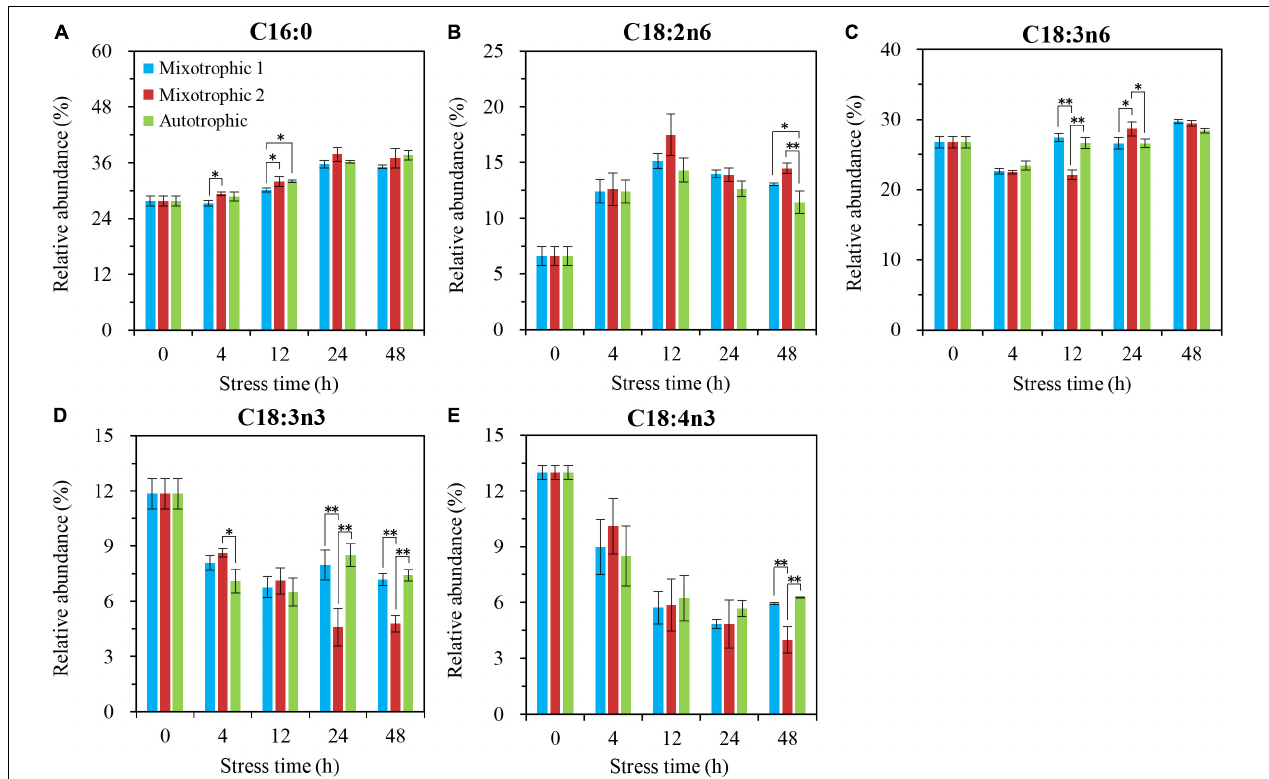
FIGURE 10 | Time course of changes in the relative abundances of the major fatty acyls in DGTS of C. reinhardtii BAFJ5 under three carbon supply regimes over 48 h of HL-N. The carbon supply regimes for mixotrophic 1, mixotrophic 2, and autotrophic were 17 mM acetate and 2% CO 2 (v/v), 17 mM acetate and ambient 0.04% CO 2 (v/v), and 2% CO 2 (v/v), respectively. Cx:ynz, where x, y, and z refer to the number of carbon, the number of double bonds, and the position of the first double bond counting from the methyl end, respectively. Values are the means of three independent replicates ± SD ( n = 3). ∗ p < 0.05; ∗∗ p <